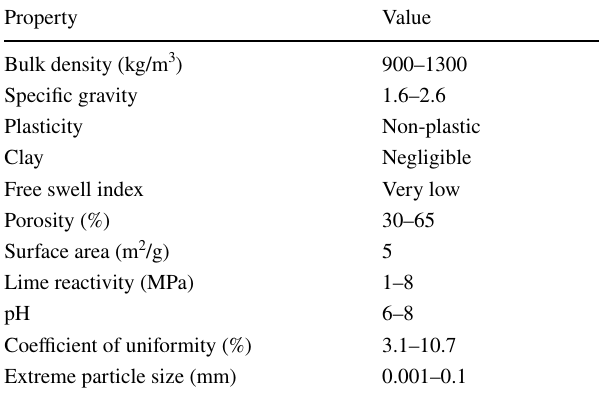
Table 2 Physico-chemical properties of CFA (Gollakota et al.